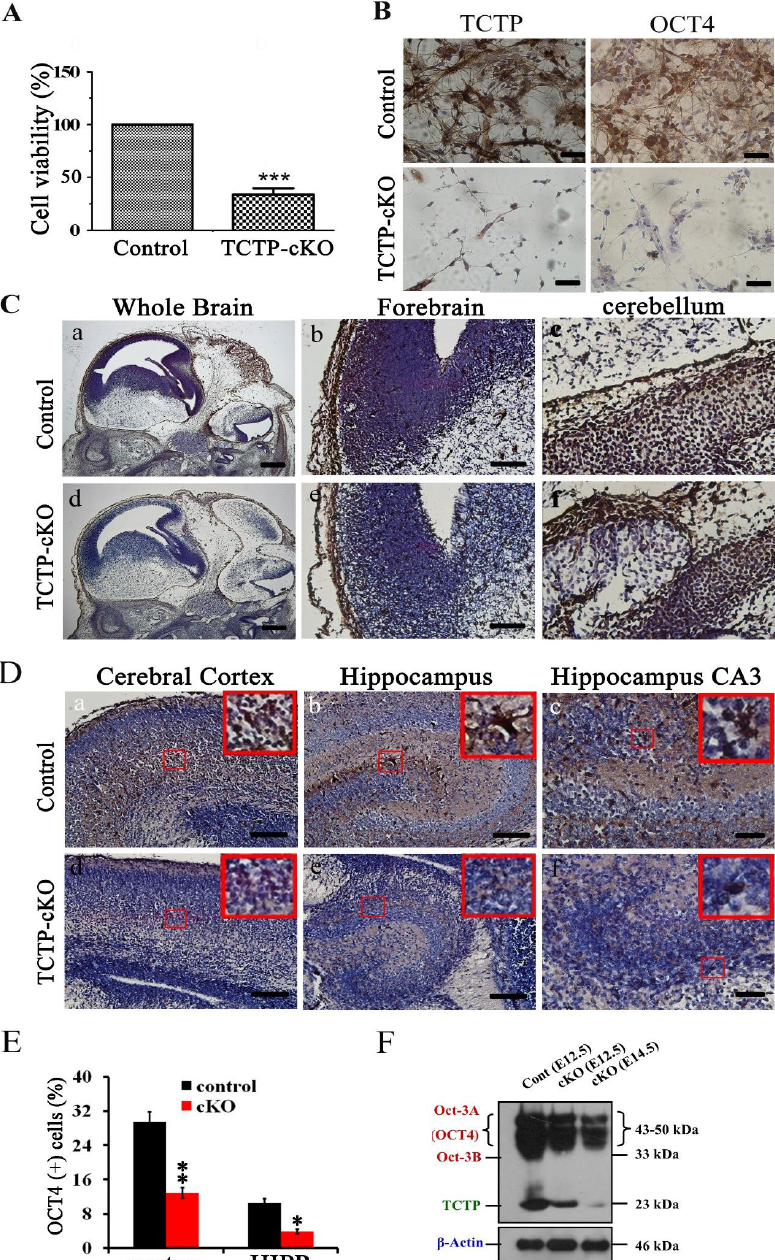
Figure 9. Cell viability and octamer-binding transcription factor 4 (Oct4) protein expression were detected in primary cortical progenitor cultures and brain sections. ( A ) Cell viability and cell number of neuron progenitor cell cultures from TCTP-deficient mice and littermate controls at E15.5 were detected by MTT assay. (*** p < 0.001, Student’s t test, n = 3 per group). ( B ) TCTP and Oct4 expression was detected by immunohistochemistry with antibody followed by DAB staining and then counterstaining with hematoxylin. ( C , D ) Oct4 expression of control and TCTP-cKO mice at E13.5 and P0.5 was detected by immunohistochemistry. A representative picture is shown for two independent experiments. ( E ) Bar graph summarizing quantification of Oct4-positive ( + ) cells in ( D ), (Data presented as mean ± SEM, * p < 0.05, ** p < 0.01, Student’s t test, n = 3 per group). ( F ) Protein level of Oct4 in control and TCTP-cKO mice was measured by Western blotting. Scale bar: A, 40 µ m; C: a, d, 400 µ m, b, c, e, f, 100 µ m; D: a, b, d, e, 100 µ m, c, f, 40 µ